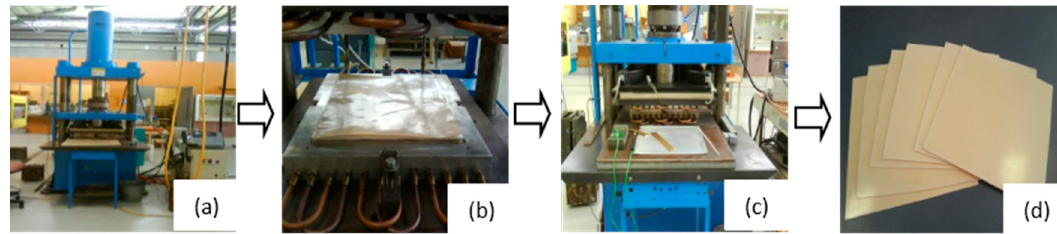
Figure 2. Manufacturing method for bamboo fabric-PLA composite sheets: ( a ) A square mould placed inside a 100 tonne hydraulic press, was heated using electrical and oil heaters; ( b ) Bamboo fabric-PLA stack was placed inside the mould; ( c ) The mould was closed without pressure for 2 min, followed by the application of 1.05 MPa pressure for 3 min; ( d ) Bamboo fabric-PLA composite